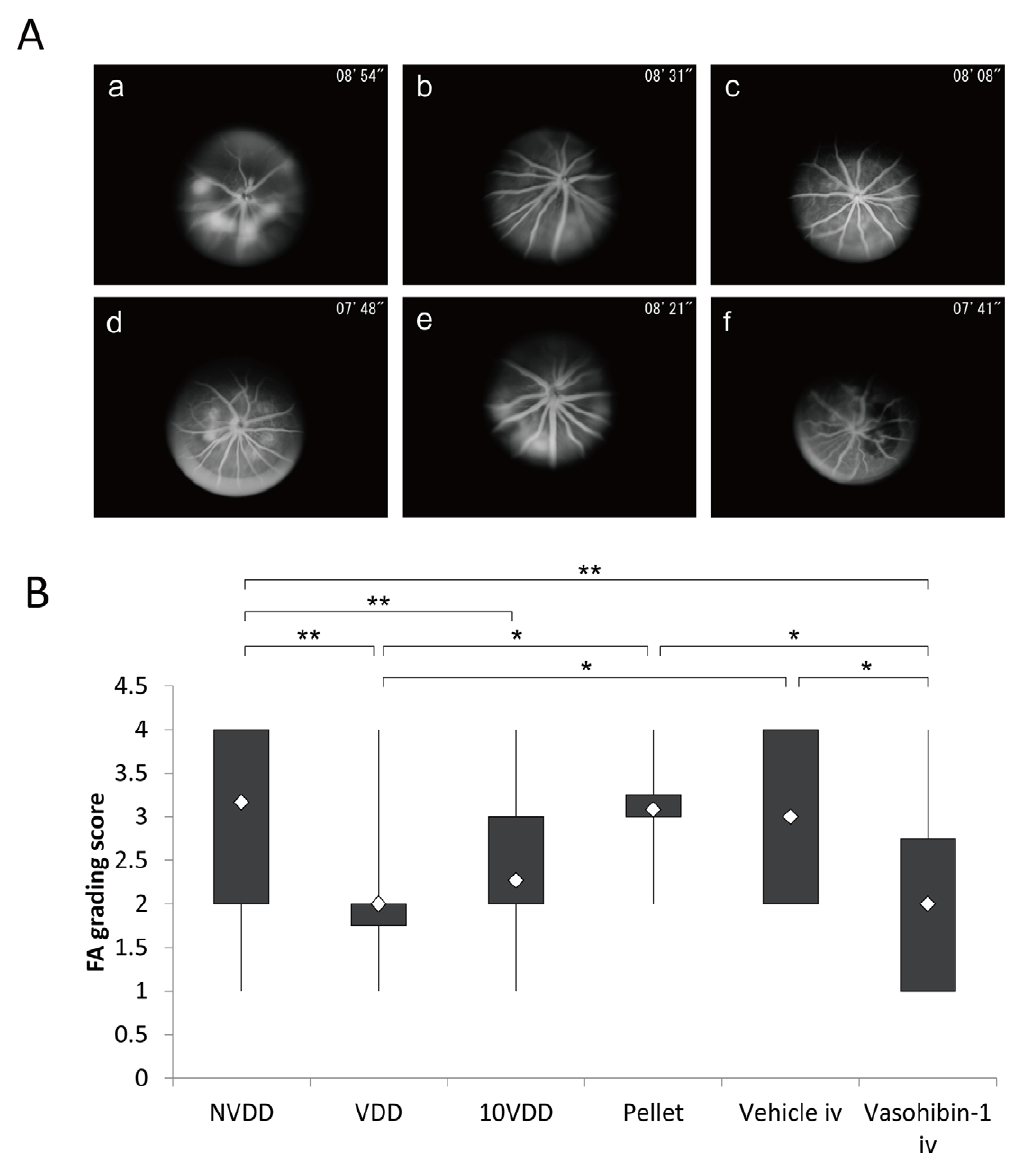
Figure 4. Fluorescein angiography 1 week after CNV laser procedure. (A) Representative results of fluorescein angiography (FA) in each group at 1 week after CNV laser procedure. The groups were treated with NVDD (a), VDD (b), 10VDD (c), vasohibin-1 pellet (d), intravitreal vehicle injection (Vehicle iv) (e), or intravitreal vasohibin-1 injection (Vasohibin-1 iv) (f). (B) Fluorescein angiography scores for each of the six laser spots in each eye are plotted and calculated for each group. Significantly lower FA scores was shown in the Vasohibin-1 iv group when compared to those of NVDD (p=0.00014), pellet (p=0.02), and Vehicle iv (p=0.040). Significantly lower FA scores are also observed in the 10VDD group when compared to the NVDD group (p=0.00006). Significantly lower FA scores are also observed in the VDD group when compared those of NVDD (p=0.00017), Pellet (p=0.012), and intravitreal vasohibin-1 injection (p=0.026). Significant differences are shown as asterisks. NVDD: non-vasohibin-1 (vehicle) delivery device, VDD: 1 m M vasohibin-1 delivery device, 10VDD: 10 m M vasohibin-1 delivery device, Pellet: vasohibin-1 pelletized at the same concentration of 10VDD (without reservoir and cover).